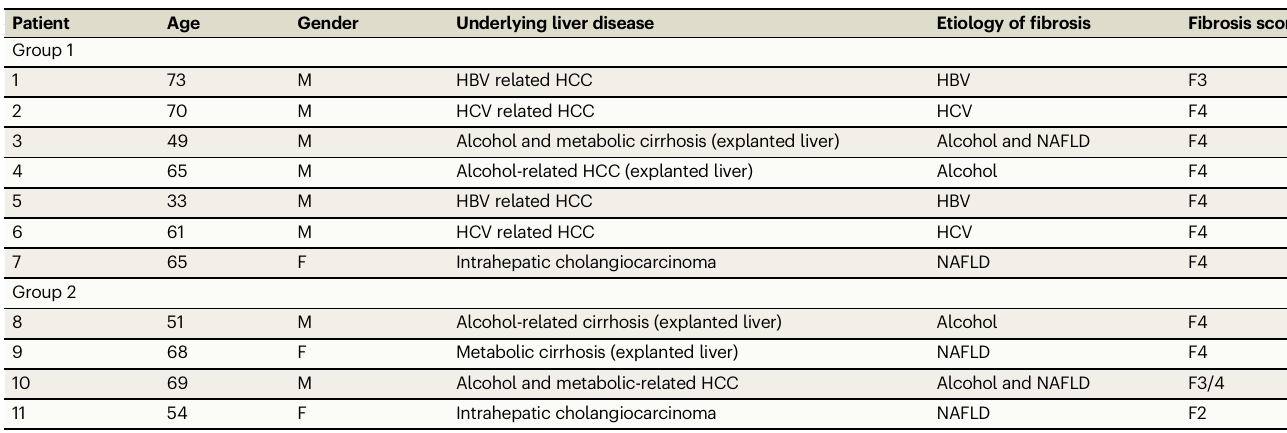
Table 1 | Patients ’